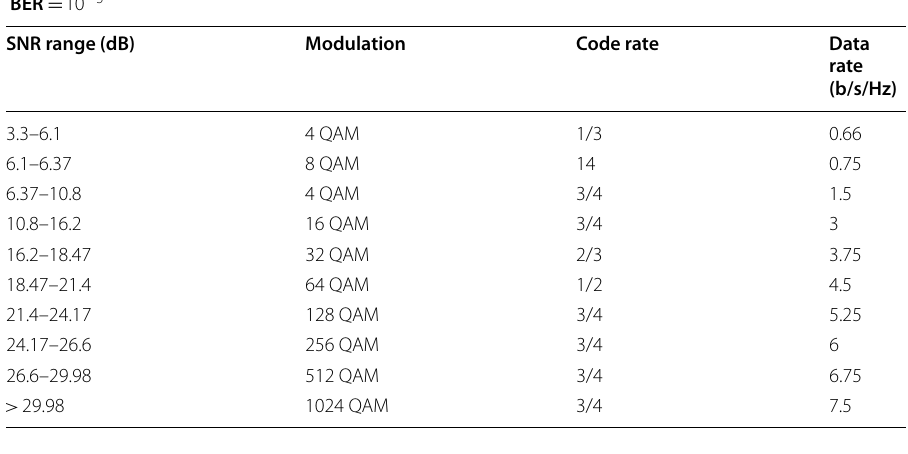
Table 8 Sample of spectrally efficient modulation-code pair which give a target BER of 10 − 5 at given range of SNR value